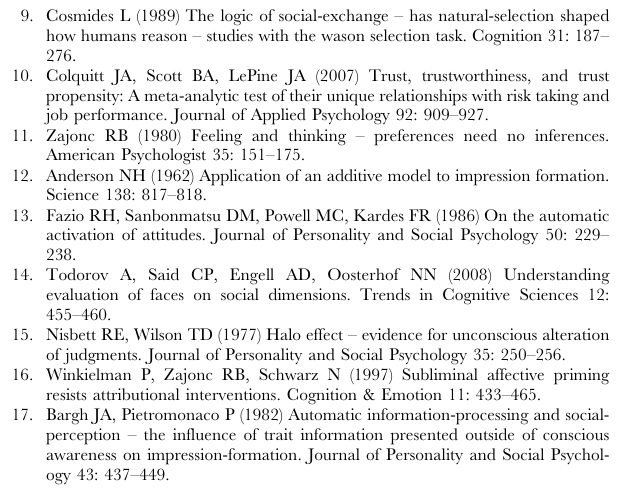
Figure S1 Change of partner judgments in three dimensions from pre- to post-game using the 7-point Likert-type scale. The columns show the mean 6 SEM. (A) Change of likability ratings. (B) Change of trustworthiness ratings.